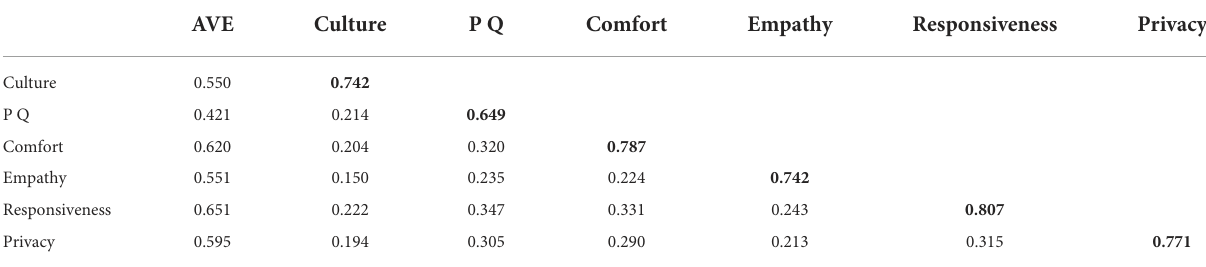
TABLE 7 Discriminative